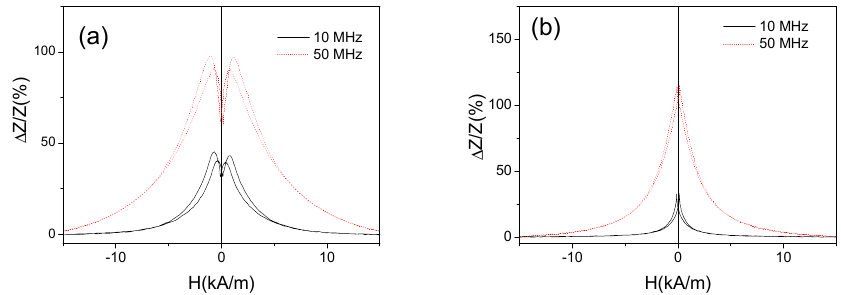
Figure 8. ∆ Z / Z ( H ) dependencies of as-prepared ( a ) and annealed at 300 ◦ C ( b ) Fe 3.6 Co 69.2 Ni 1 B 12.5 Figure 8. Δ Z/Z ( H ) dependencies of as-prepared ( a ) and annealed at 300 °C Si 11 Mo 1.5 C 1.2 ( b ) Fe 3.6 Co 69.2 Ni 1 B 12.5 Si 11 Mo 1.5 C 1.2 microwires.